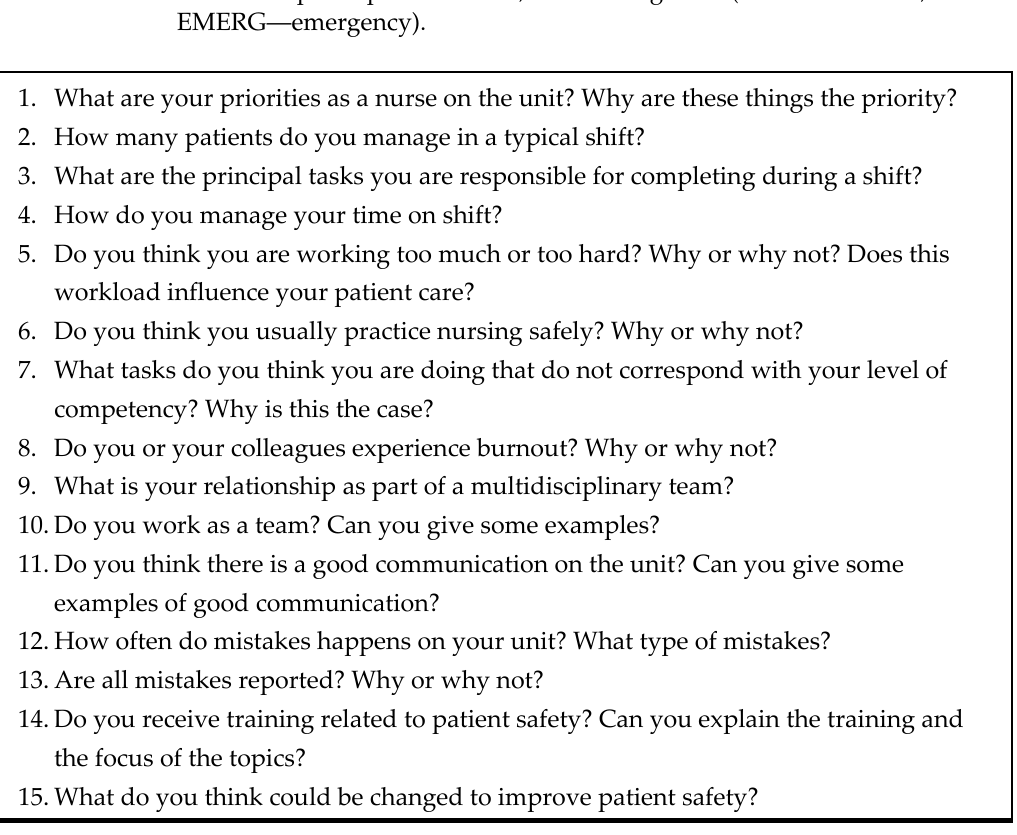
Figure 1. Semi-structured interview